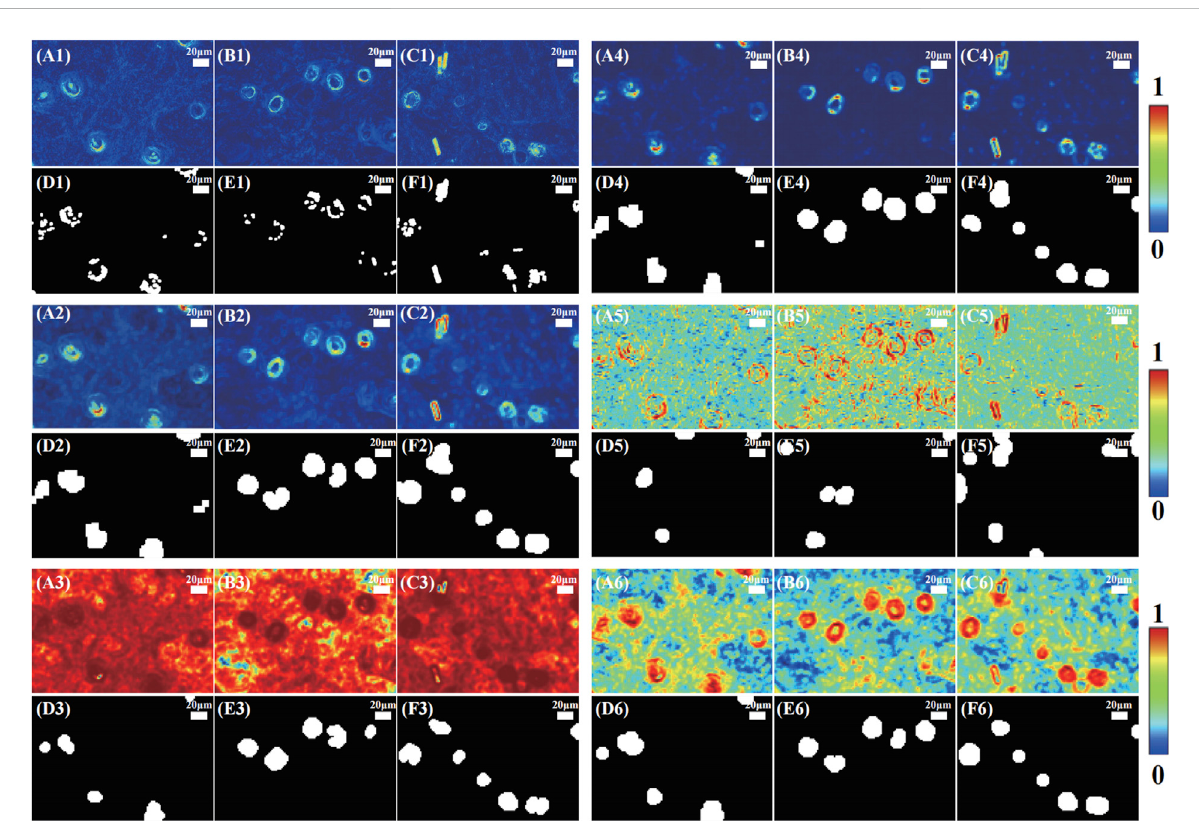
FIGURE 5 Hair follicle region segmentation results of three mouse skin tissue samples. (A1,C1) are the original MMPD δ parameter images, (D1,F1) are the corresponding segmentation results at the reduction rates of four times; (A2,C2) are the sliding window images of TIPM contrast, (D2,F2) are the correspondingsegmentationresults; (A3,C3) aretheslidingwindowimagesofGLCM1-energy, (D3,F3) arethecorrespondingsegmentationresults; (A4,C4) are the sliding window images of GLCM contrast, (D4,F4) are the corresponding segmentation results; (A5,C5) are the sliding window imagesofGLCMcorrelation, (D5,F5) arethecorrespondingsegmentationresults; (A6,C6) aretheslidingwindowimagesofGLCM1-IDM, (D6,F6) are the corresponding segmentation results. All the scale bars in sub fi gures represent 20 μ m